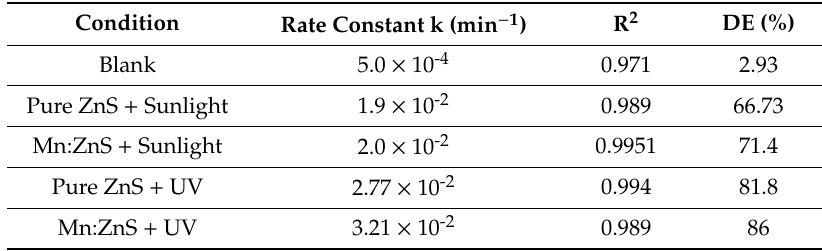
Figure 17. ( a ) Changes in the corresponding maximum wavelength of NOFX. ( b ) First order kinetic model fitting to the QDs-based photocatalytic degradation of NOFX data with Mn:ZnS QDs under Table 2. Parameters for the removal of NOFX by Mn:ZnS QDs.